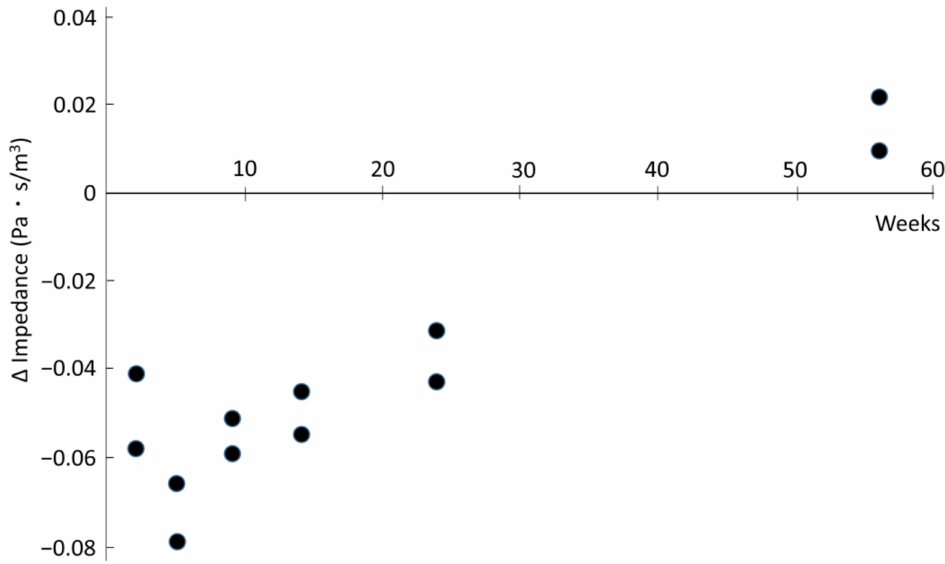
Figure 2. Changes in acoustic impedance in the liver over time. The acoustic impedance of liver tissue in the group fed the methionine and choline diet showed a temporary decrease until 5 weeks after the start of the experiment, and then increased. Solid circles indicate the degree of difference in the impedance relative to that of a control mouse on each occasion.